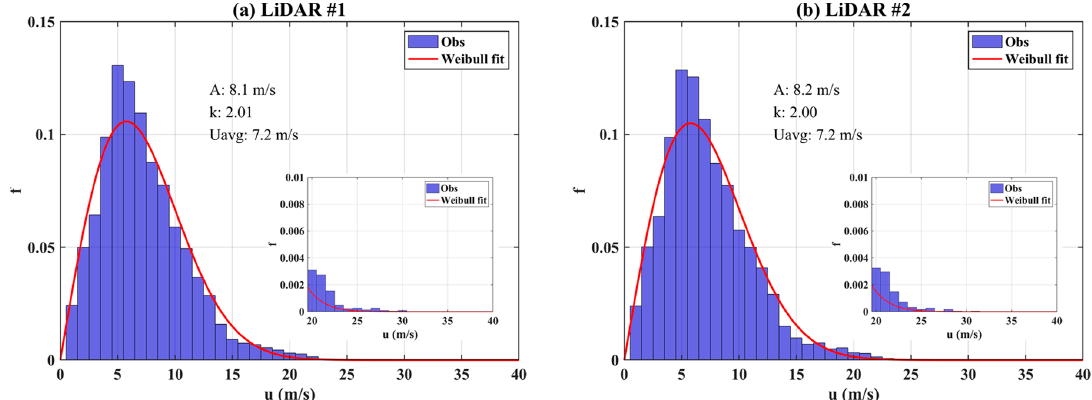
Figure 8. Comparison of occurrence frequency of 10 min wind speed for LiDAR #1 and LiDAR #2 at a height of 100 m from the LiDAR installation levels.